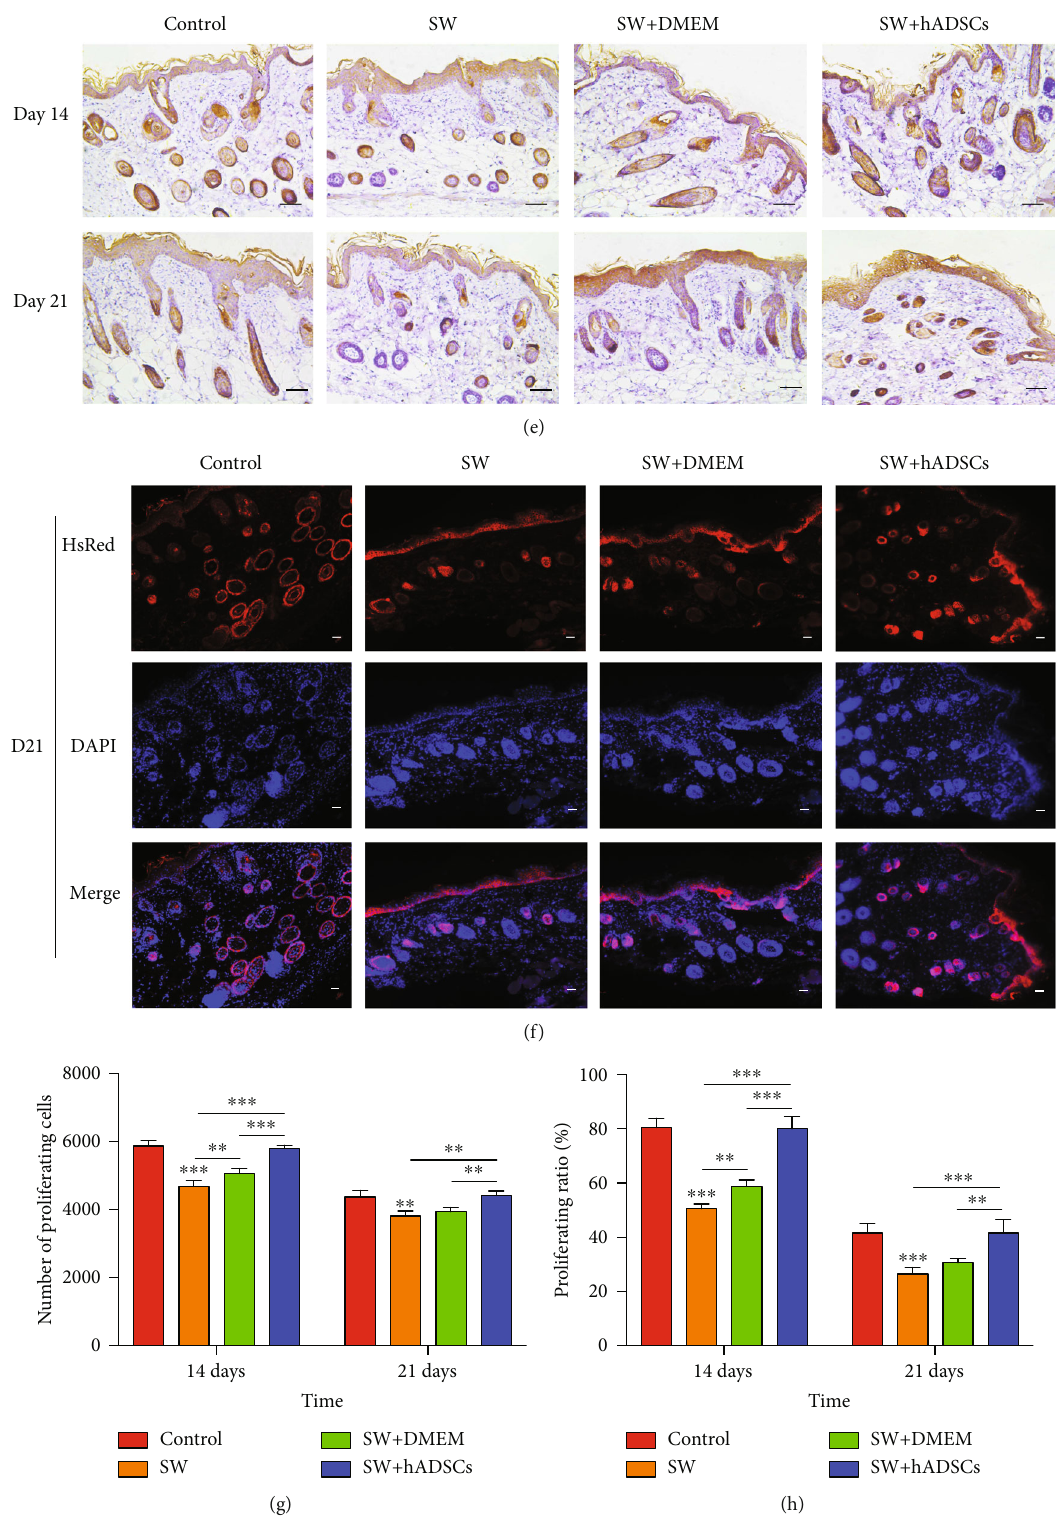
Figure 5: Ki67 and CK19 expression during wound repair after SW and hADSC treatments. The number and proportion of proliferating cells, as determined by Ki67 immunohistochemical and immuno fl uorescence (red) (a – d). The number and proportion of skin stem cells, as determined by cytokeratin 19 immunohistochemical and immuno fl uorescence (red) (e – h). DAPI staining shows the nuclei of tissues (blue). The number and proportion of proliferating cells or skin stem cells in the control group and the SW+hADSC group were signi fi cantly higher than those in the SW group. Scale bars indicate 100 μ m. ∗ P < 0 : 05 , ∗∗ P < 0 : 01 , and ∗∗∗ P < 0 : 001